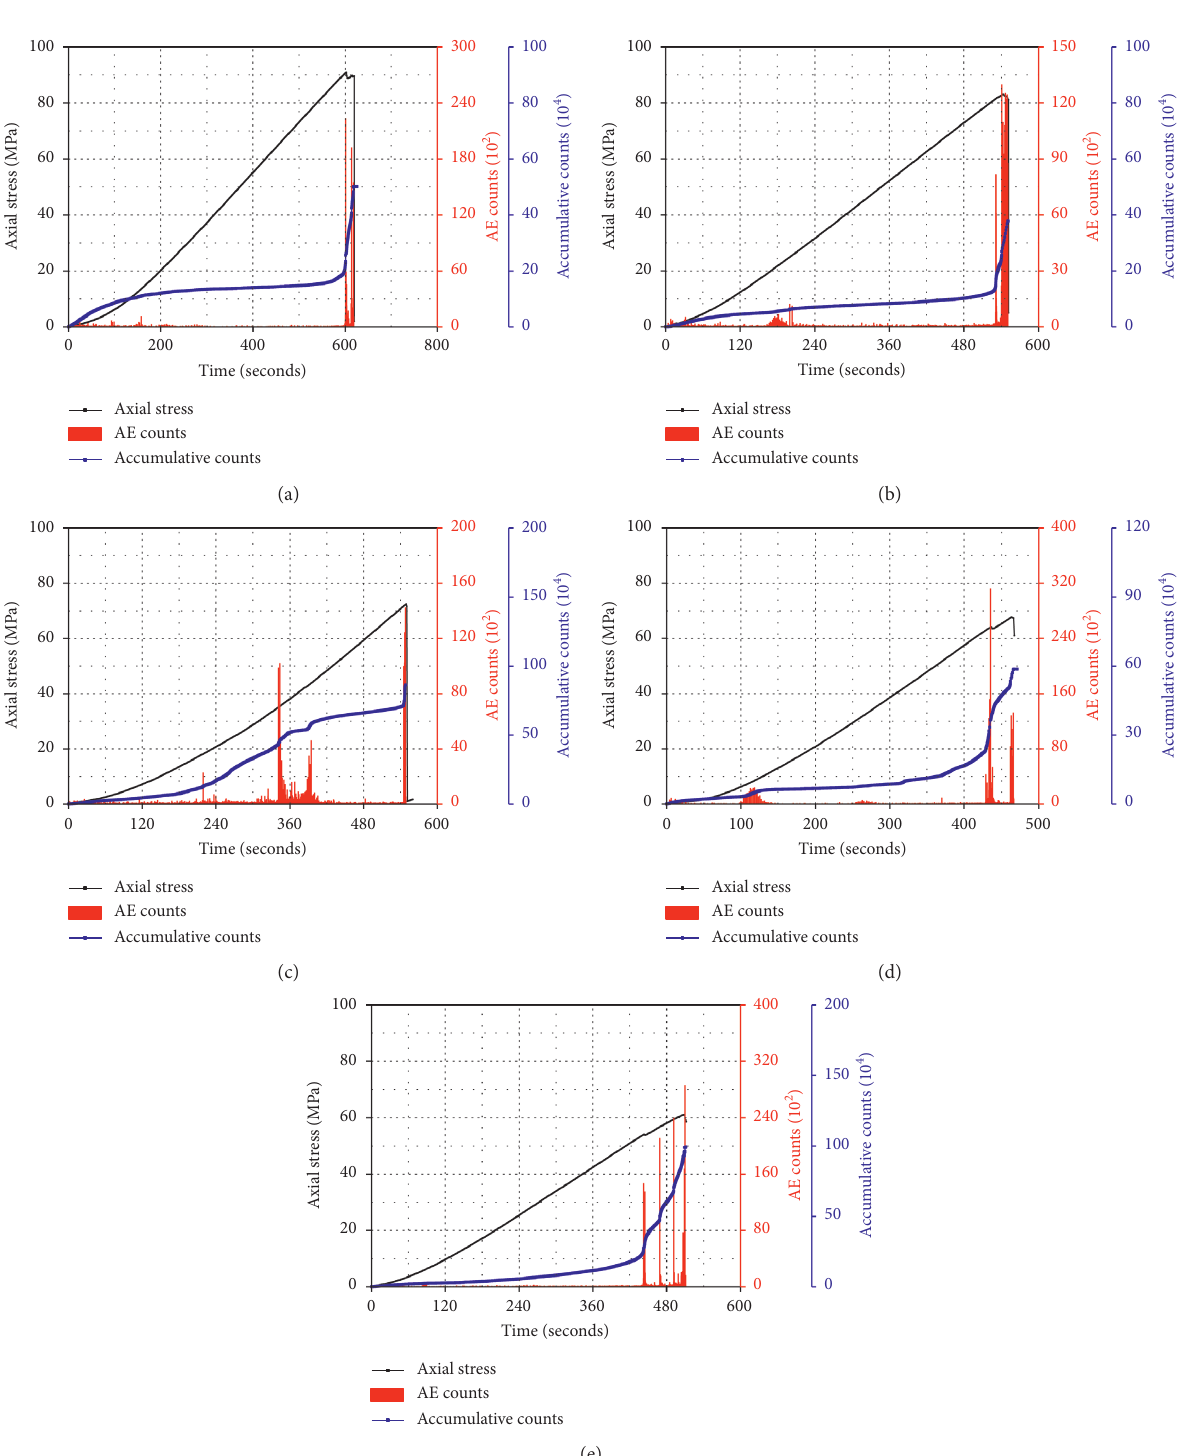
Figure 13: AE curves of specimens containing rough joint with different joint lengths, i.e., (a) specimen S1-1# ( l � 20.0mm, α � 60 ° ), (b) specimen S2-1# ( l � 27.1mm, α � 60 ° ), (c) specimen S3-2# ( l � 30.6mm, α � 60 ° ), (d) specimen S4-1# ( l � 35.6mm, α � 60 ° ), and (e) Specimen S5-2# ( l � 40.0mm, α � 60 ° ) under uniaxial